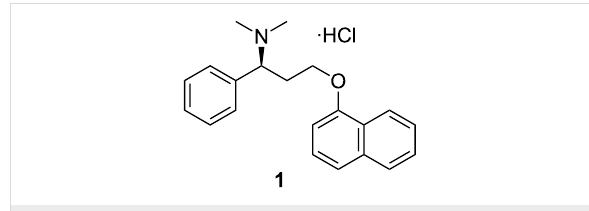
Figure 1: Dapoxetine hydrochloride ( 1